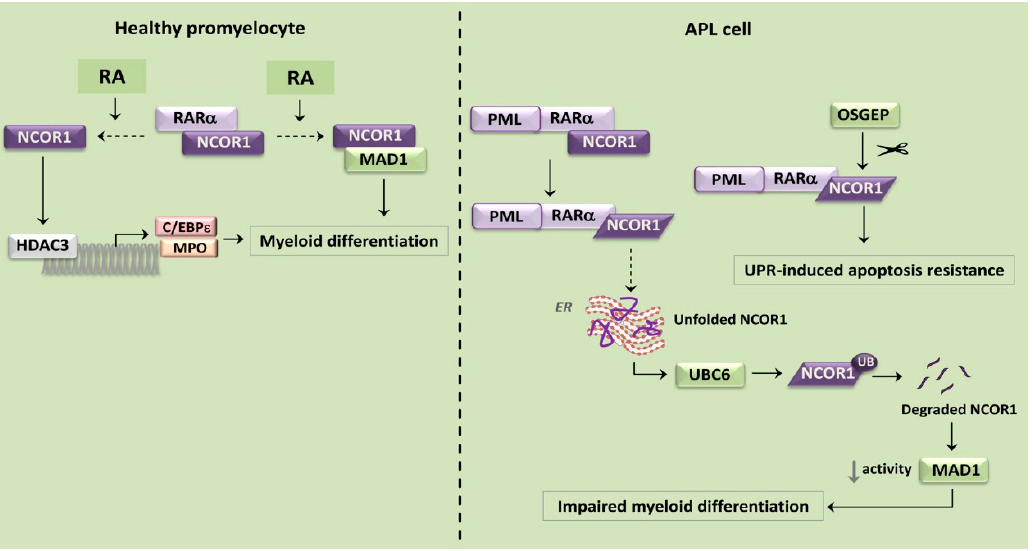
Figure 3. Involvement of unfolded protein response (UPR) in acute promyelocytic leukemia (APL). In healthy promyelocytes retinoic acid (RA) dissociates retinoic acid receptor α (RAR α) from Nuclear receptor corepressor 1 (NCOR1). NCOR1 enhances myeloid differentiation through histone deacetylase 3-myeloperoxidase-CCAAT/enhancer binding protein ε (HDAC3-MPO-C/EBP ε) signaling and association with the tumor suppressor Max dimerization protein 1 (MAD1) (left panel). In APL cells, promyelocytic leukemia-retinoic acid receptor α (PML-RAR α ) binds NCOR1 thereby inducing